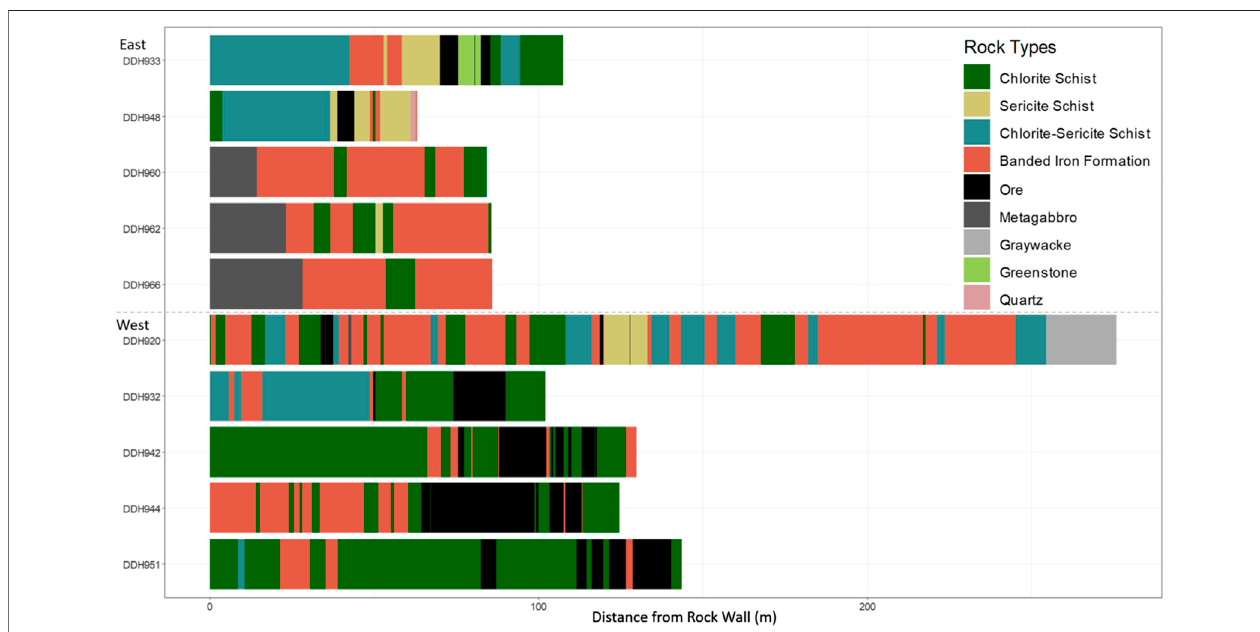
FIGURE1| Lithologiesaccessedbytheboreholesofinterestinthisstudy,compiledfromdriller ’ slogsandgeologicmapsoftheSoudanUndergroundMine ’ s27th level. DDH 964 was not included, as records of the lithologies it accessed could not be found.